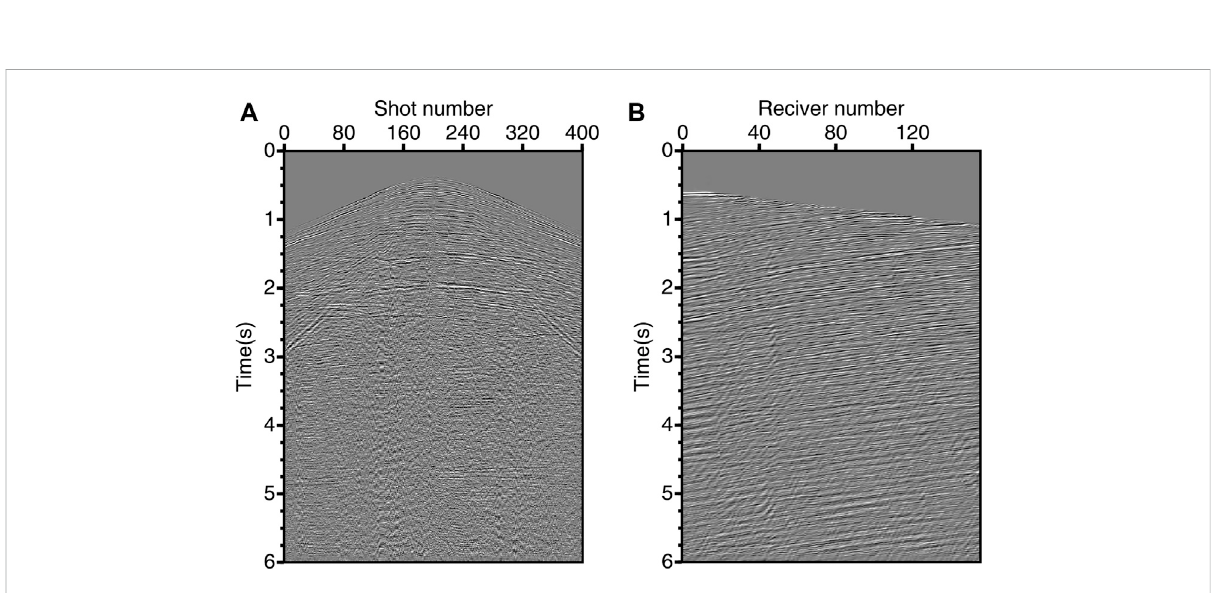
FIGURE 10 (A) The common receiver record. (B) The common shot